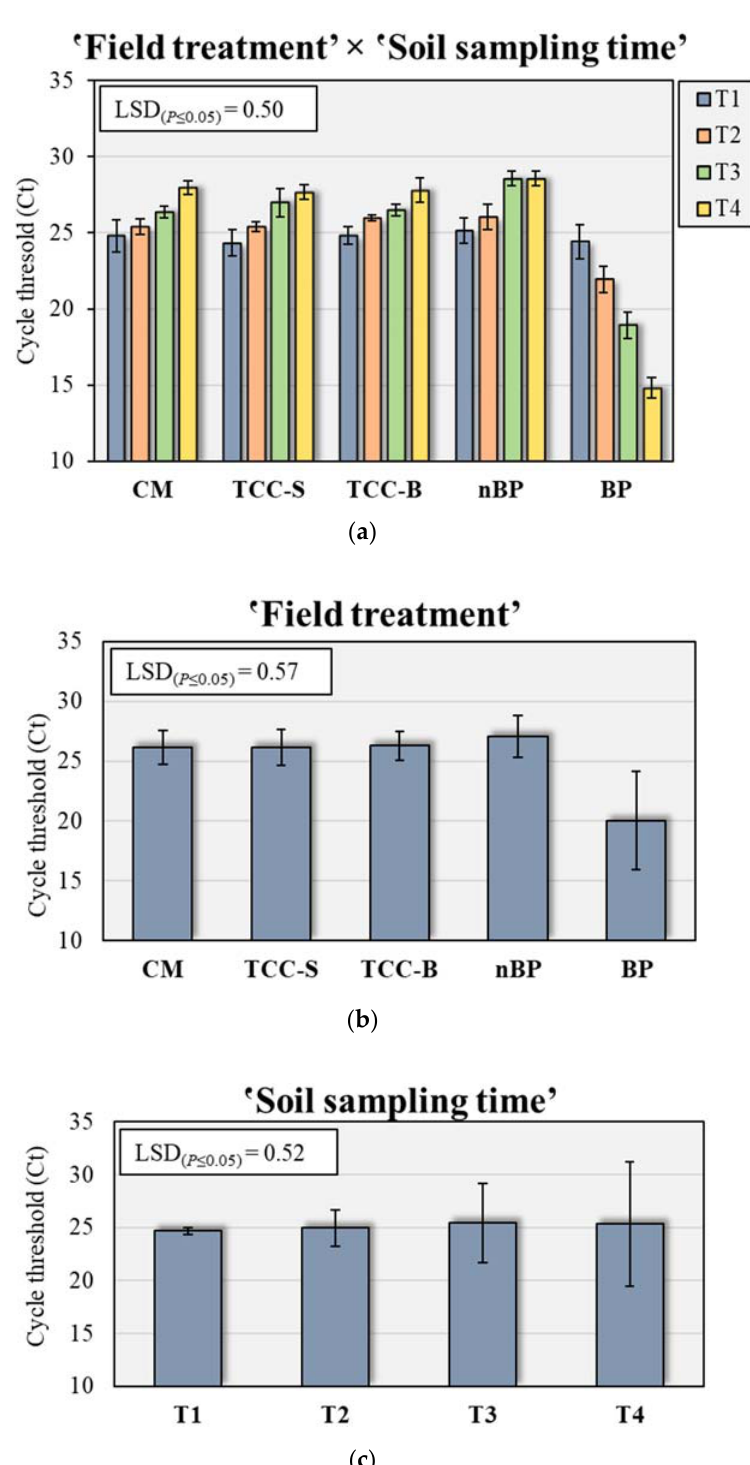
Figure 5. ( a ) Amount of Pseudomons putida detected by qRT ‐ PCR over five different field treatments ( b ) and four soil sampling times ( c ). The Least Significant Difference (LSD) interaction was calculated with the Fisher’s protected LSD test at α = 0.05. Each bar indicates means ± standard deviation. Ct levels are inversely proportional to the amount of target nucleic acids in the soil sample. CM, conventional apricot management; TCC ‐ S, Trifolium subterraneum L. cover cropping leaving dead mulch on the soil surface; TCC ‐ B, T. subterraneum cover cropping burying dead mulch in the soil; nBP, no ‐